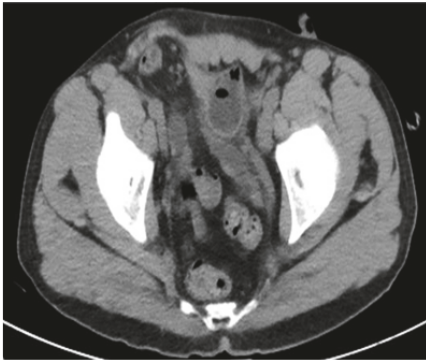
Figure 2: CT image demonstrates narrowing of bilateral dilated ureters entering the inguinal canal.